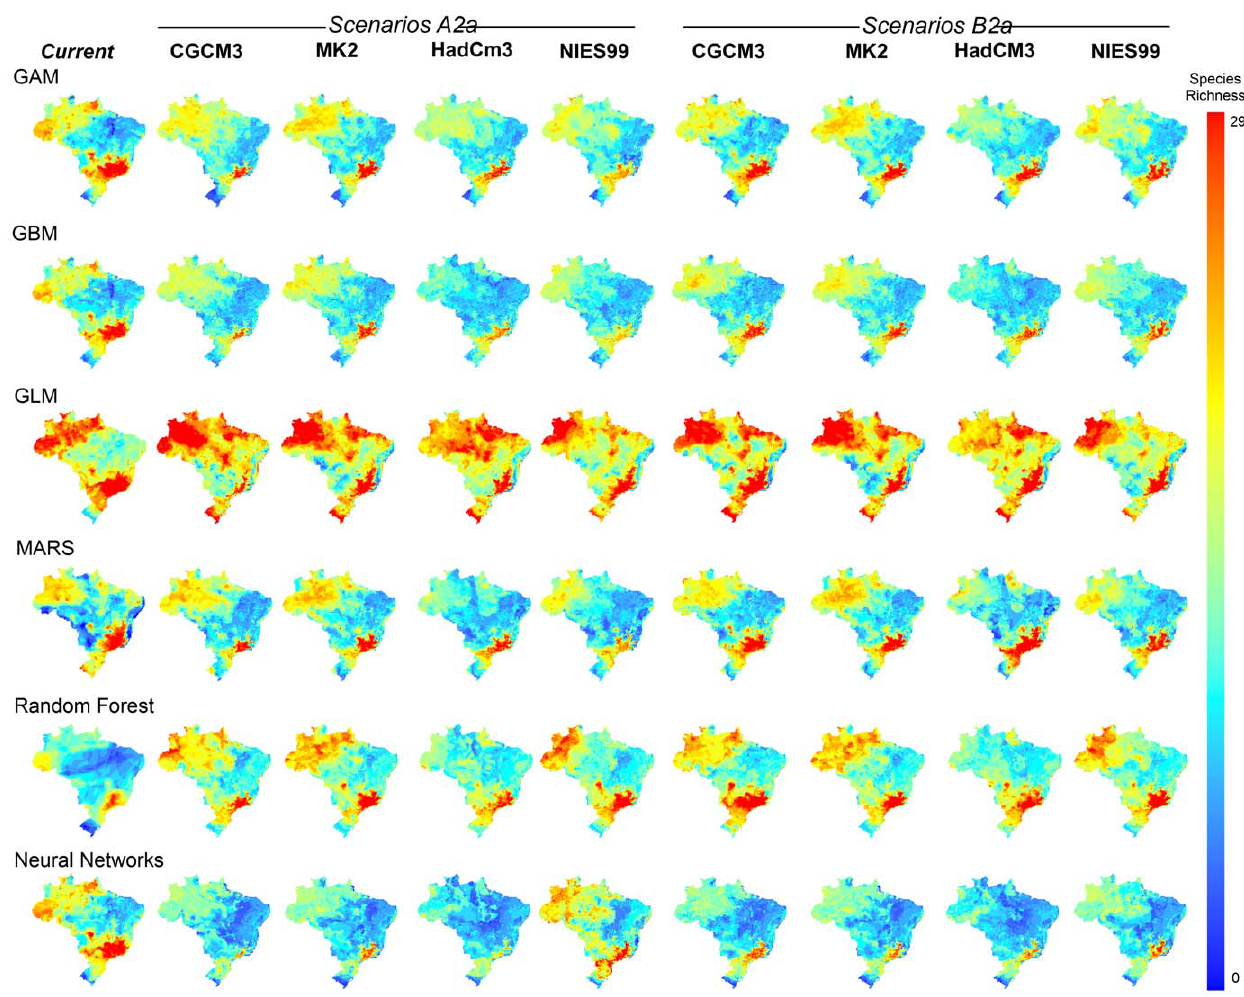
Figure 1. Marsupial species richness patterns in Brazil (current and future, 2050) forecasted by species distribution models generated by different modeling methods (Generalized Additive Models, GAM; Generalized Boosting Regression Models, GBM; Generalized Linear Models, GLM; Multivariate Adaptive Regression Splines, MARS; Artificial Neural Networks, ANN; and Random Forest), climate models (CGCM3, MK2, HadCm3, NIES99), and green house gases emission scenarios (optimist, B2a, and pessimist, A2a). See text for further details.